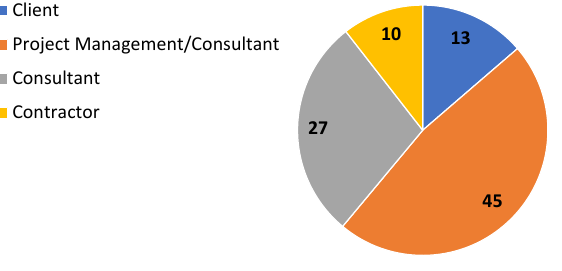
Figure 1. Category of participants.